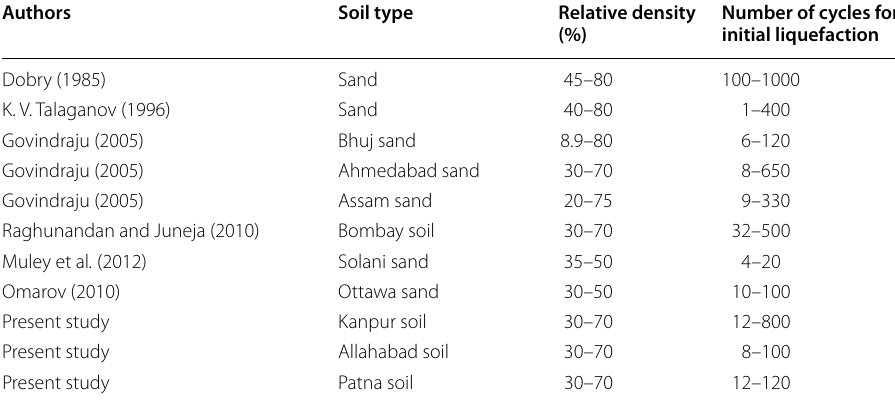
Table 4 Comparison of liquefaction potential of present study with previous studies Authors Soil type Relative density